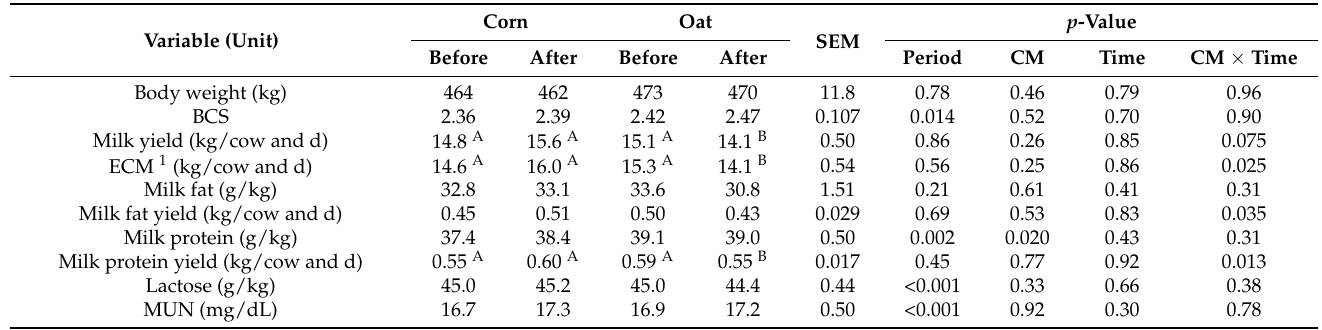
Table 4. Body weight, body condition score, milk yield, and chemical composition of milk of lactating Brown Swiss cows grazing a mixed alfalfa-ryegrass sward and supplemented with a corn- or oat- based concentrate mixture before or after grazing (least-squares means, standard errors of means (SEM); n =